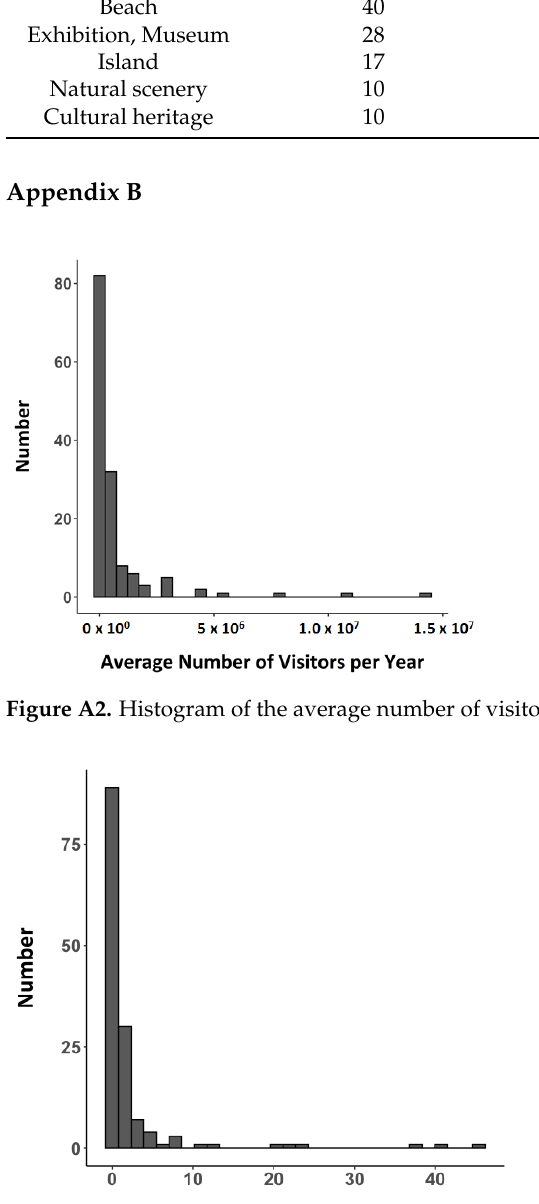
Figure A4. Histogram of the annual average daily Twitter users.